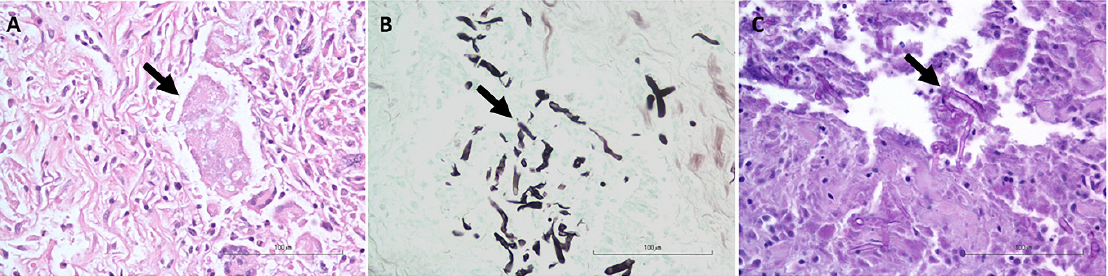
Figure 2. Representative photomicrographs for the histopathologic identification of hyphae morphologically consistent with Pythium sp. (arrows). ( A ). H&E stain; ( B ). GMS stain; and ( C ). PAS stain.